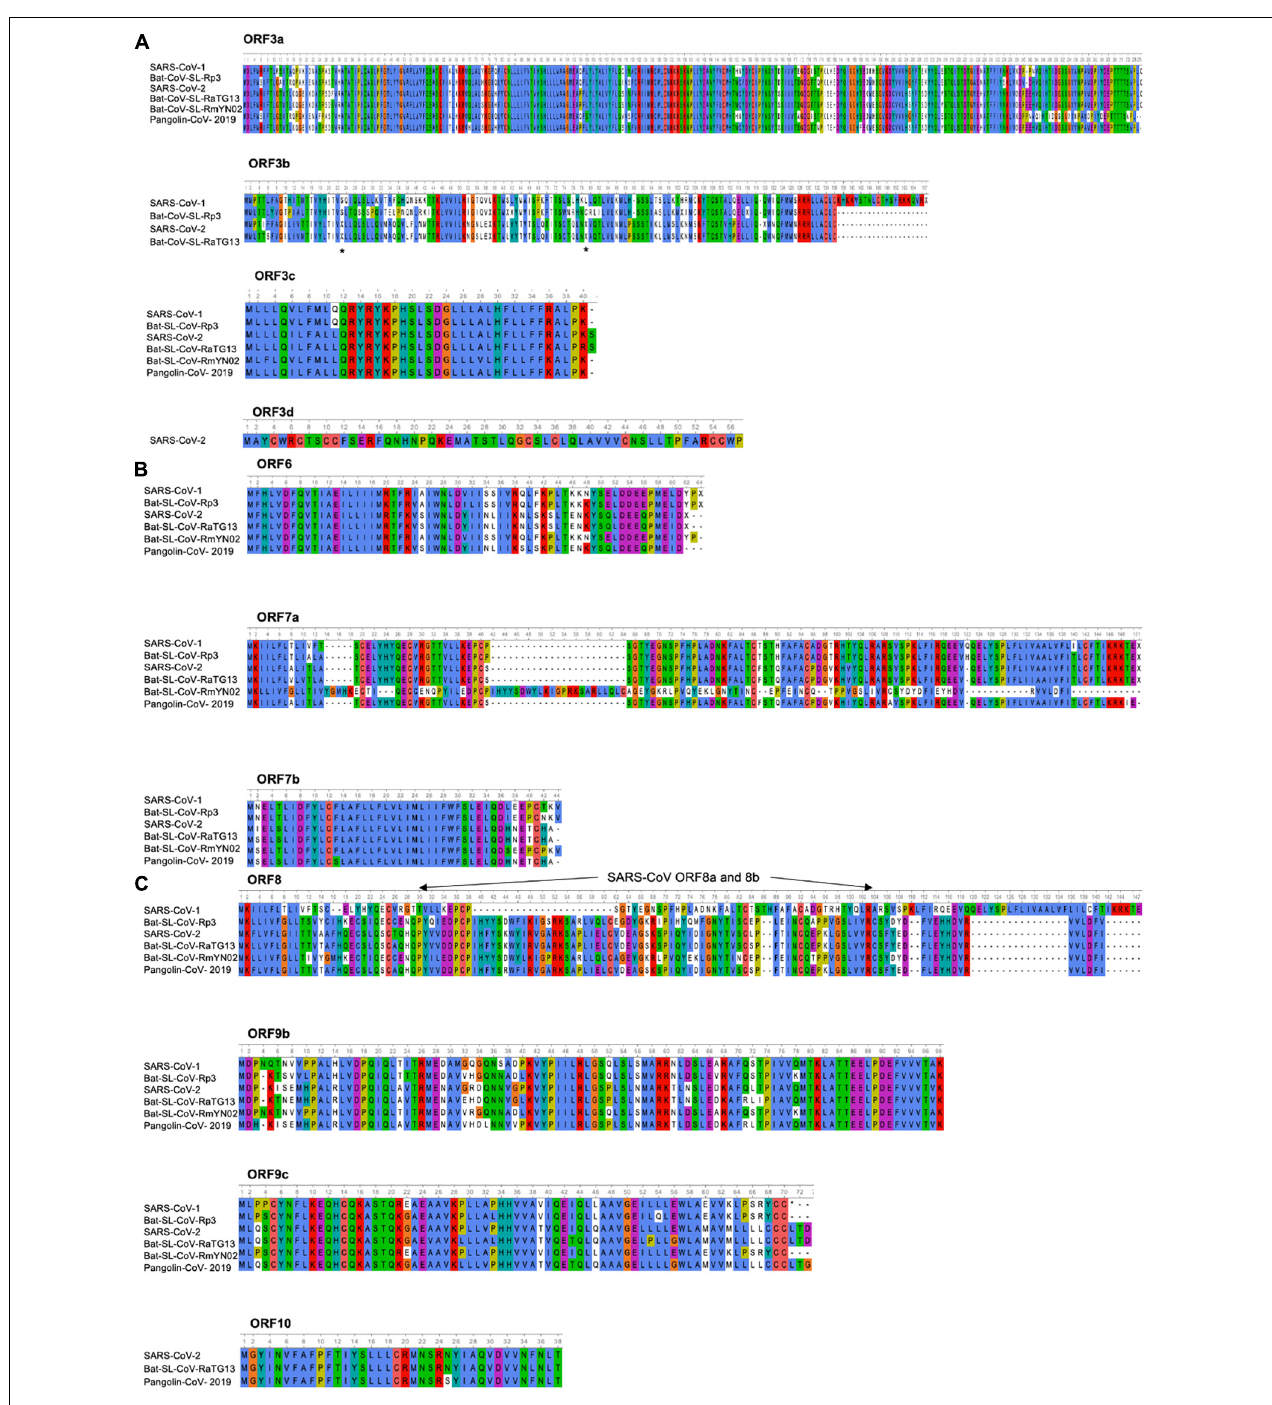
FIGURE 4 | Amino acid alignment of ORFs encoding accessory proteins. (A) Amino acid alignment of ORF3a and 3b sequences of SARS-CoV-1 (AY274119), Bat-SL-CoV-Rp3 (DQ071615), SARS-CoV-2 (NC_045512), Bat-SL-CoV-RaTG13 (MN996532), Bat-SL-CoV-RmYN02 (JX993988), Pangolin-CoV-2019 (MT121216). No ORF3b is found in the Bat-SL-CoV-RmYN02 and Pangolin-CoV-2019 sequences, the stars indicate the stop codons. Amino acid alignment of ORF3c and 3d sequences. ORF3d is only found in the SARS-CoV-2. The asterisks indicate the stop codons. (B) Amino acid alignment of ORF6, 7a and 7b sequences. (C) Amino acid alignment of ORF8, 9b, 9c, and 10 sequences. The SARS-CoV-1 ORF8 went through a gradual deletion over the course of the epidemic and at the end of the outbreak ORF8 was divided in 2 ORFS (ORF8a and 8b). ORF10 is only found in SARS-CoV-2, Bat-SL-CoV-RaTG13 and Pangolin-CoV-2019. Sequences were analyzed using Unipro UGENE: a unified bioinformatics tollkit Okonechnikov; Golosova; Fursov. Bioinformatics 2012 28: 1,166–1,167. Amino-acids are color-coded according Clustal X. For each ORF, the SARS-CoV-2 sequence (NC_045512) was used as a reference sequence to perform the alignment.